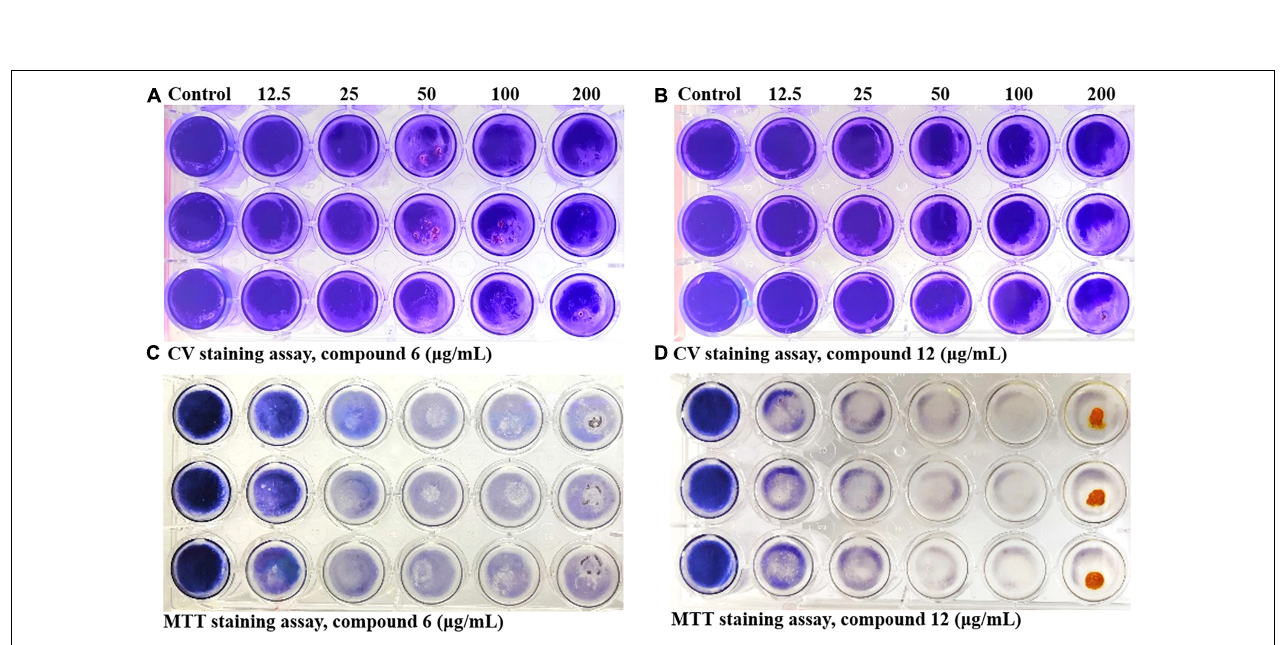
FIGURE 4 | Dose-dependent effects of compounds 6 and 12 against MRSA biofilms qualified by two different staining methods. The 24-h preformed MRSA biofilms were treated with increasing concentrations of compounds 6 and 12 (12.5–200 µ g/ml) for another 24 h before staining with CV (A,B) or MTT (C,D) solution. The same volume of DMSO was used as negative control. At least three independent experiments were conducted, and there were three biological replicates each time.